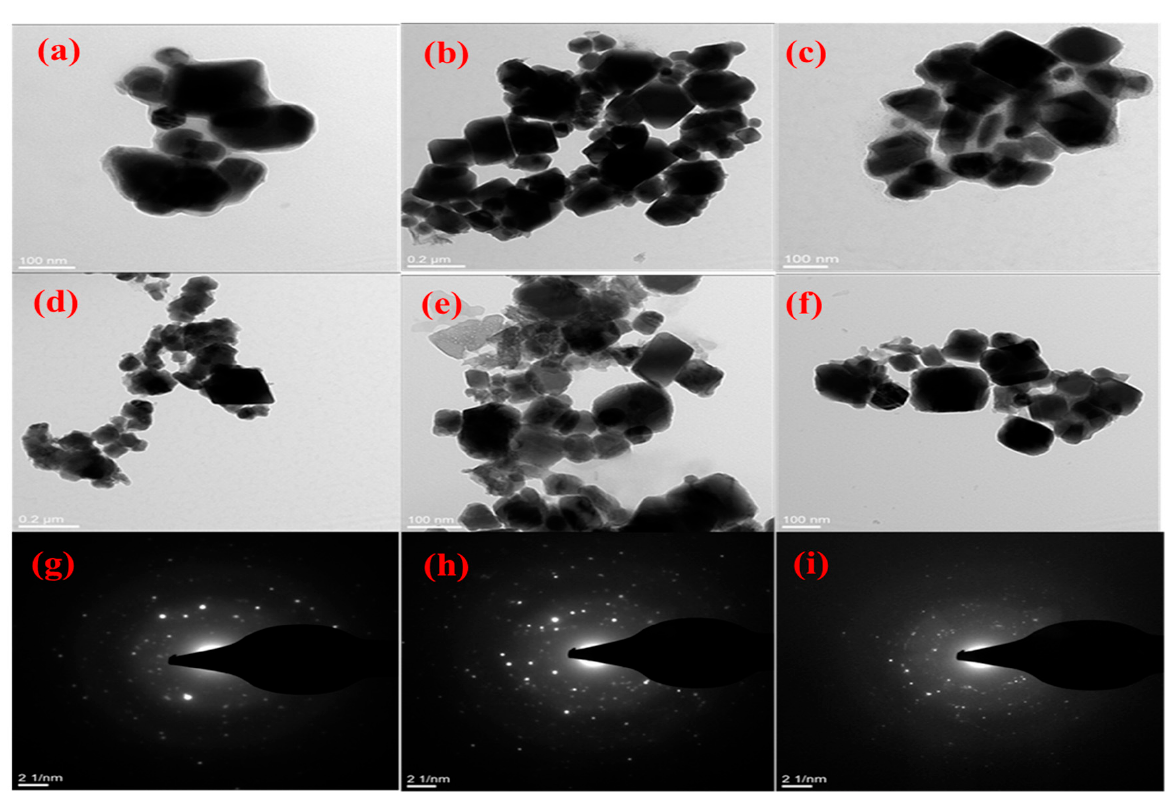
Figure 5. TEM images of Cu x S y nanoparticles prepared in ( a , d ) OLA, ( b , e ) HDA, and ( c , f ) DDA at 190 °C using complexes 1 and 2; SAED patterns of nanoparticles prepared in ( g ) OLA, ( h ) HDA and ( i ) DDA at 190 °C from complex 1.